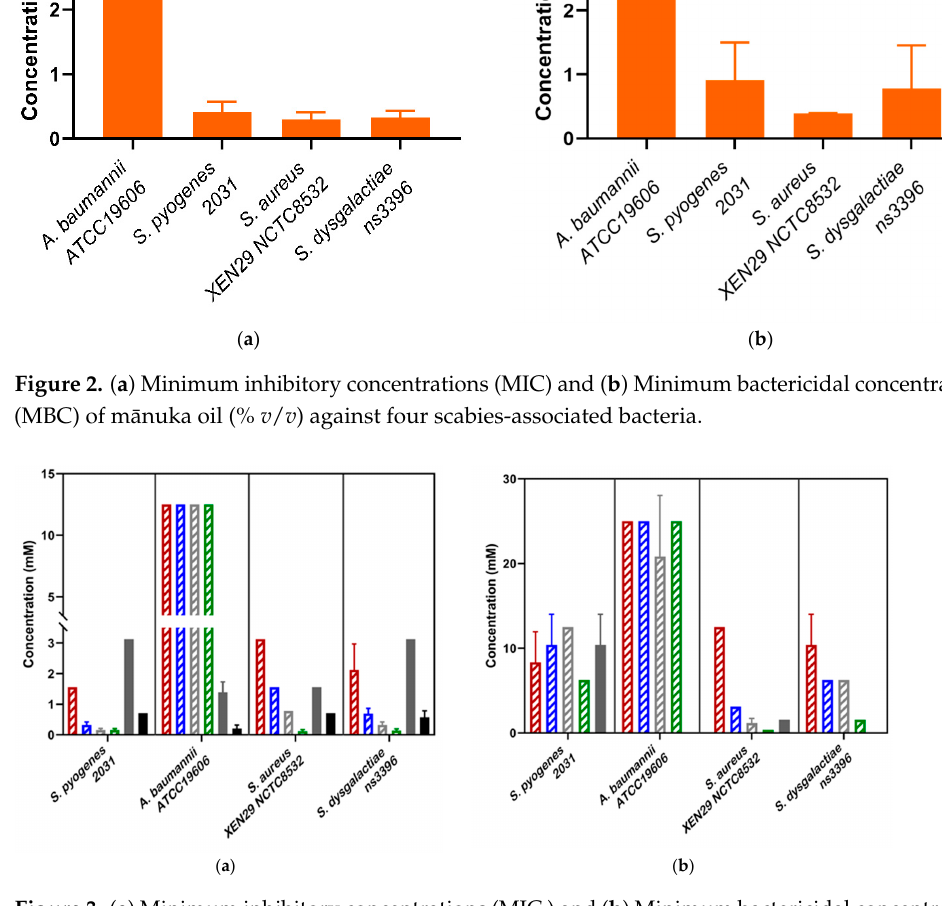
Figure 3. ( a ) Minimum inhibitory concentrations (MIC ) and ( b ) Minimum bactericidal concentrations (MBC) of novel scabicides against four scabies-associated bacteria. For all Streptococcus strains, the pure Ivermectin formulation was used. For S. aureus and A. baumannii , the Ivomec Pour-on Solution was used. Ivermectin did not show bactericidal activity against all strains tested. In the above bar chart, the β -triketones are shown in a striped pattern, with Flavesone in red, isoleptospermone in blue, leptospermone in grey and grandiflorone in green stripes. Abemetapir is presented in solid grey and ivermectin in in solid